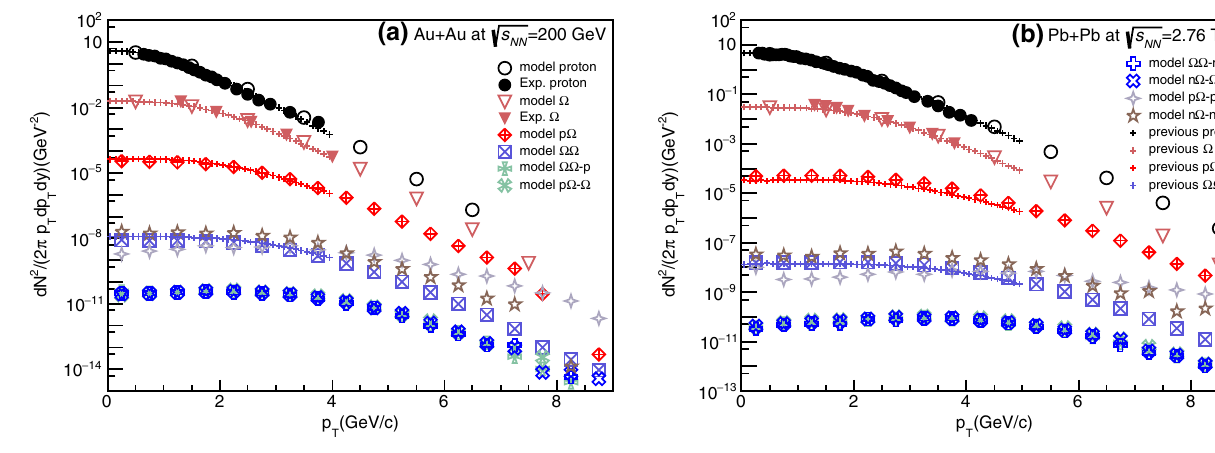
the data from the RHIC [67,72,73] and ALICE [69–71]. The lines are calculated by our previous work